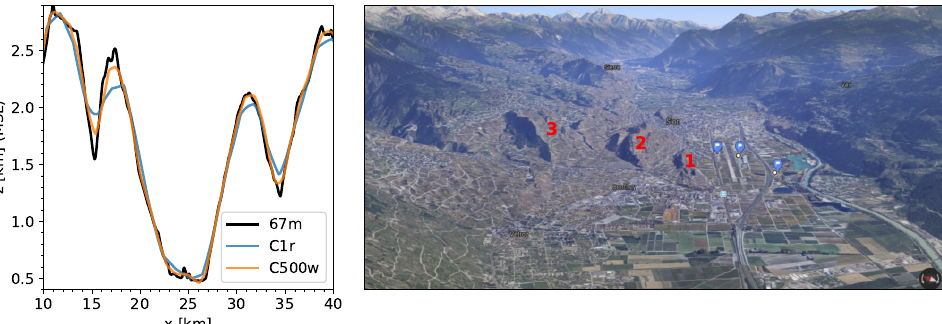
Figure 8. Local conditions at Sion. Left panel: Terrain height along the valley cross-section shown in Figure 1 at three different resolutions: original ASTER data (67 m), filtered for 1 km simulations (C1), and for 500 m simulations (C500); Right panel: Three-dimensional view of the Sion area (Google Maps). The numbers indicate the location of the three small hills discussed in the